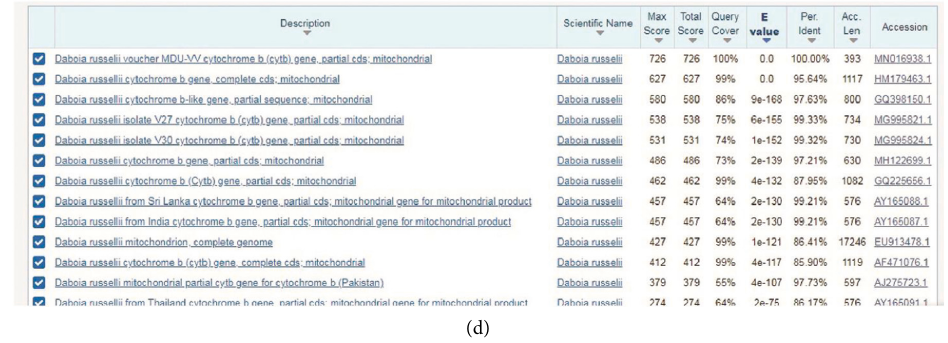
Figure 3: (a, b) Phylogenetic tree of Naja naja (a) made using the Neighbour-joining method. Sequence labelling is performed by taxonomic name (Sequence ID) and sequence alignment homology for Naja naja query sequence. (b) Sequence highlighted in yellow is query sequence (FASTA sequence is presented in supplementary data file). Phylogenetic tree of Daboia russelii (c) made using the Neighbour-joining method. Sequence labelling is performed by taxonomic name (Sequence ID) and sequence alignment homology for Daboia russelii query sequence. (d) Sequence highlighted in yellow is query sequence (FASTA sequence is presented in supplementary data file).